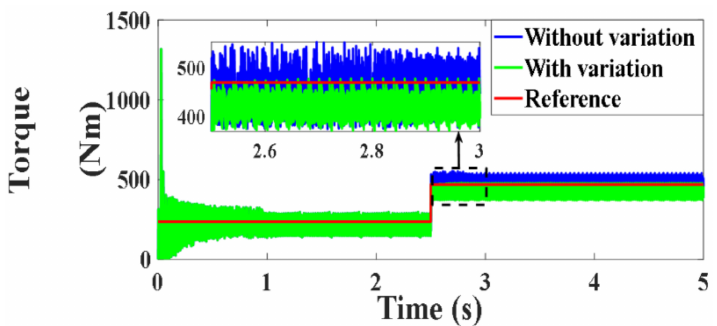
Figure 159. Developed torque under PVC (Nm).